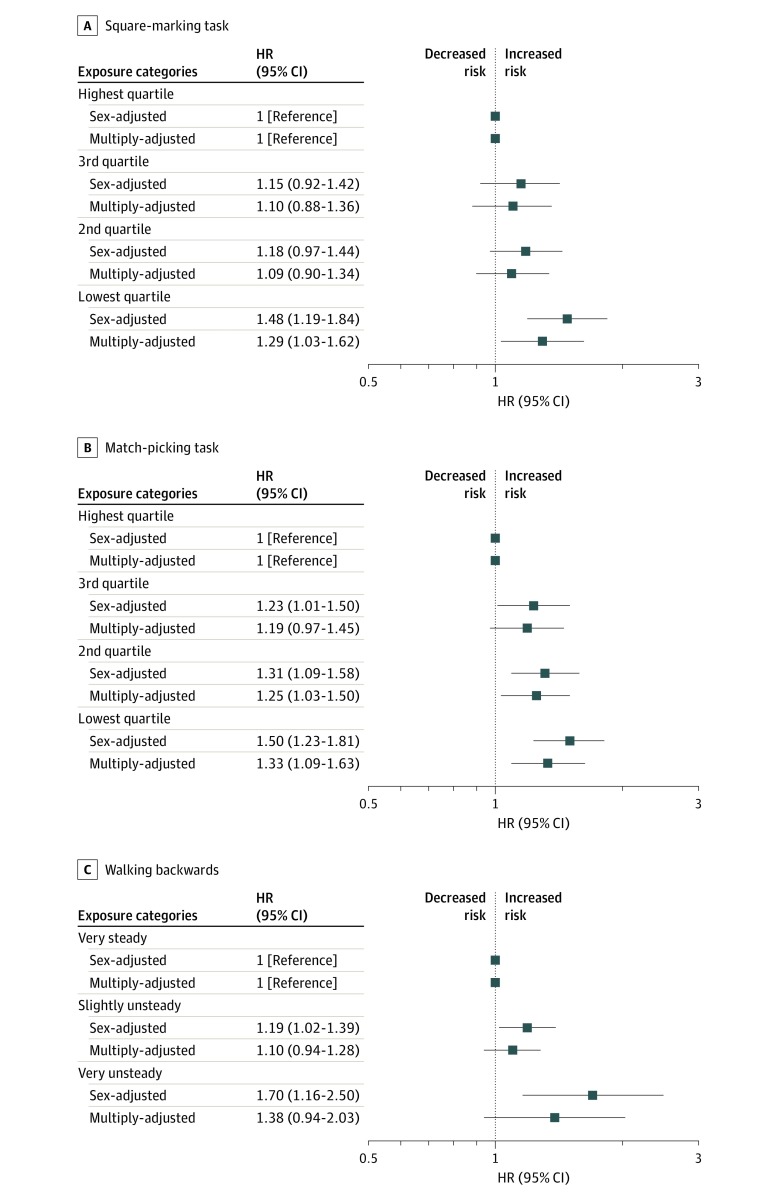
Association of Square Marking, Match Picking, and Walking Backward at Age 11 Years With All-cause Mortality by 58 YearsTests were conducted for square marking (A), match picking (B), and walking backward (C). HR indicates hazard ratio; error bars, 95% CI. Multiple adjustment is adjustment for childhood socioeconomic, health, cognitive, and developmental factors as listed in Table 1.